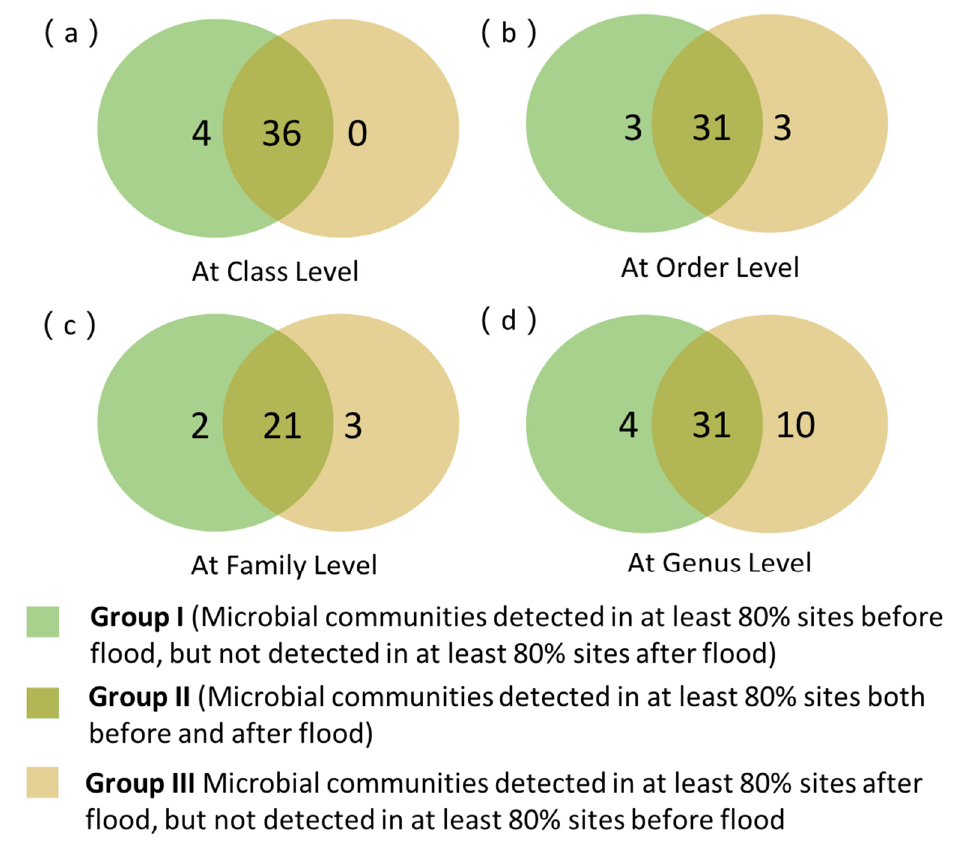
Figure 5. Venn diagram demonstrating shared and unique eukaryotic taxa at class, order, family, and genus level in samples collected before and after the floods. Detailed data of eukaryotic taxa are shown in Table S2.